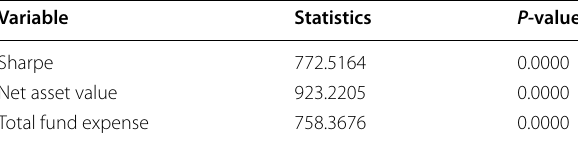
Table 4 Unit root statistical summary. Source : calculated by